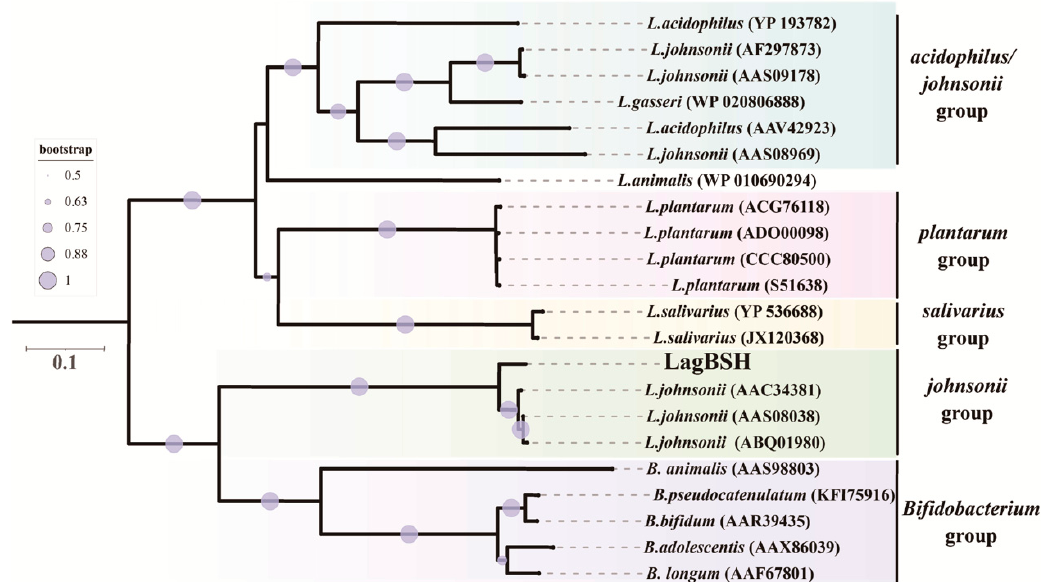
Figure 4. Phylogenetic analysis of LagBSH with cholylglycine hydrolase family proteins. The phylogenetic tree was constructed with MEGA X software using the neighbor-joining method (1000 bootstrap replications) [39]. Bootstrap values greater than 50% are shown by circle symbols whose size correlates with the bootstrap values. CpBSH, BSH from Clostridium perfringens 13, was used as an outgroup.